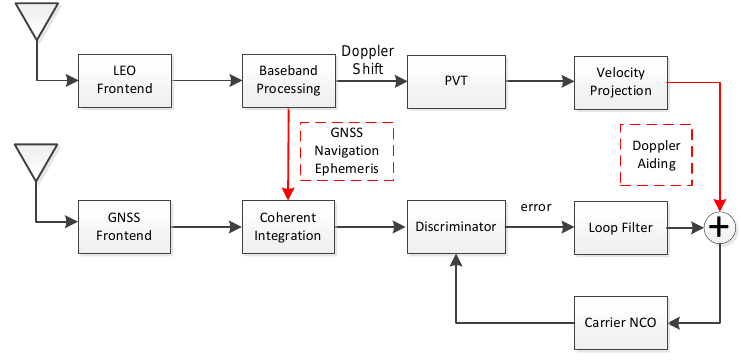
Figure 3. LEO-assisted carrier tracking loop structure.